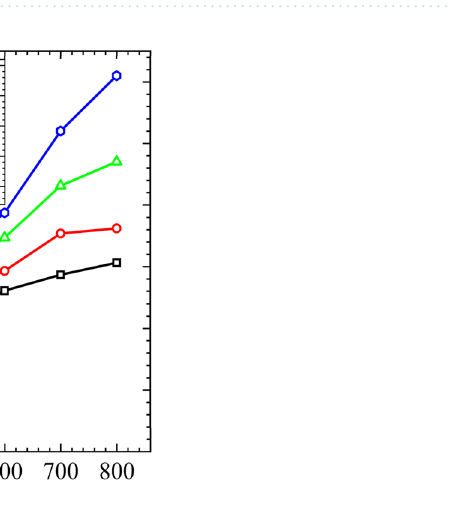
Figure 6. Spectral responsivity of AlGaAs/GaAs DH for different temperatures at zero bias. The respective EQE is showed as dashed lines.